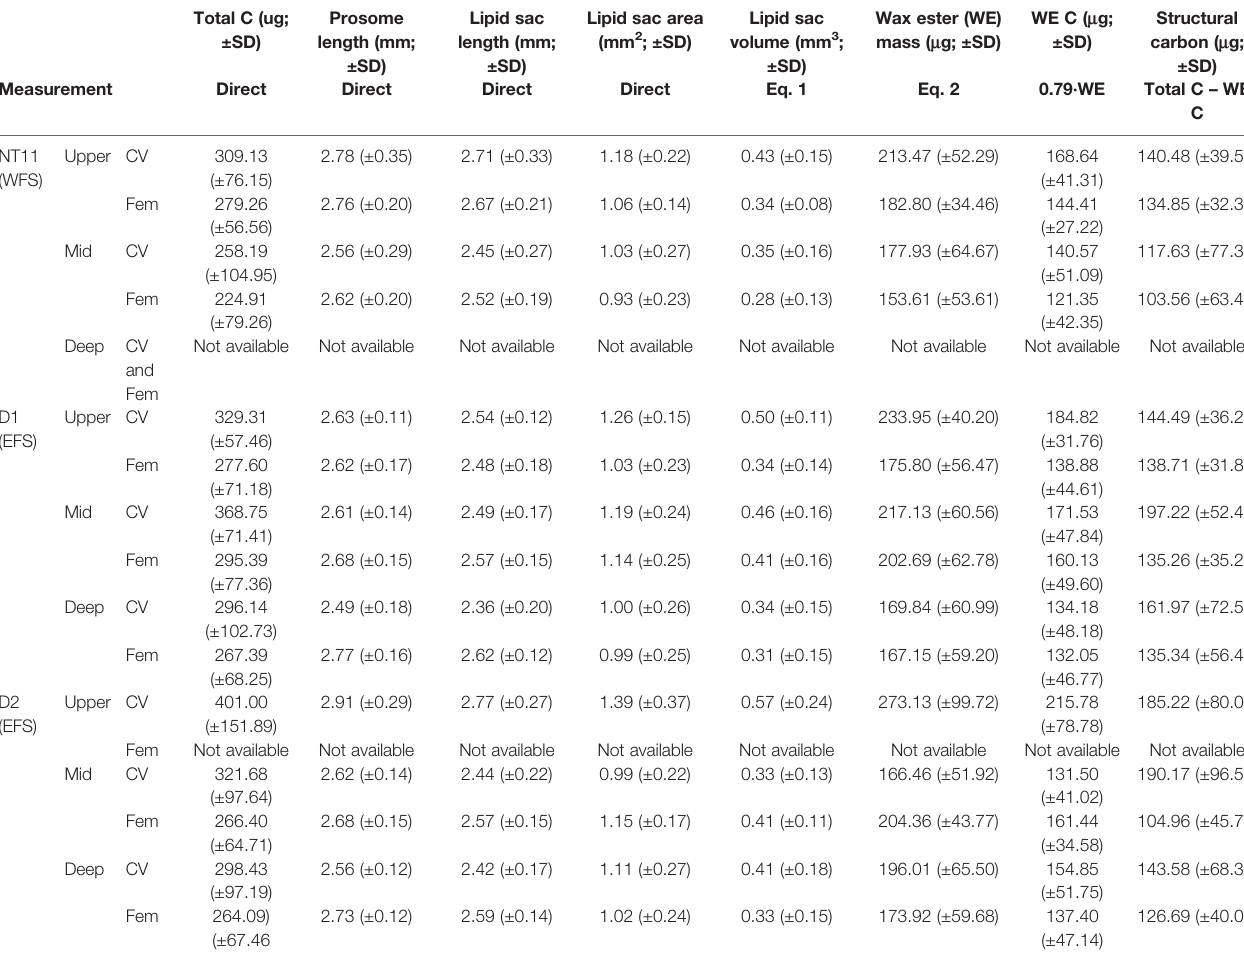
TABLE 5 | Calanus fi nmarchicus : Body conditions metrics for CV and females captured at three locations in the Fram